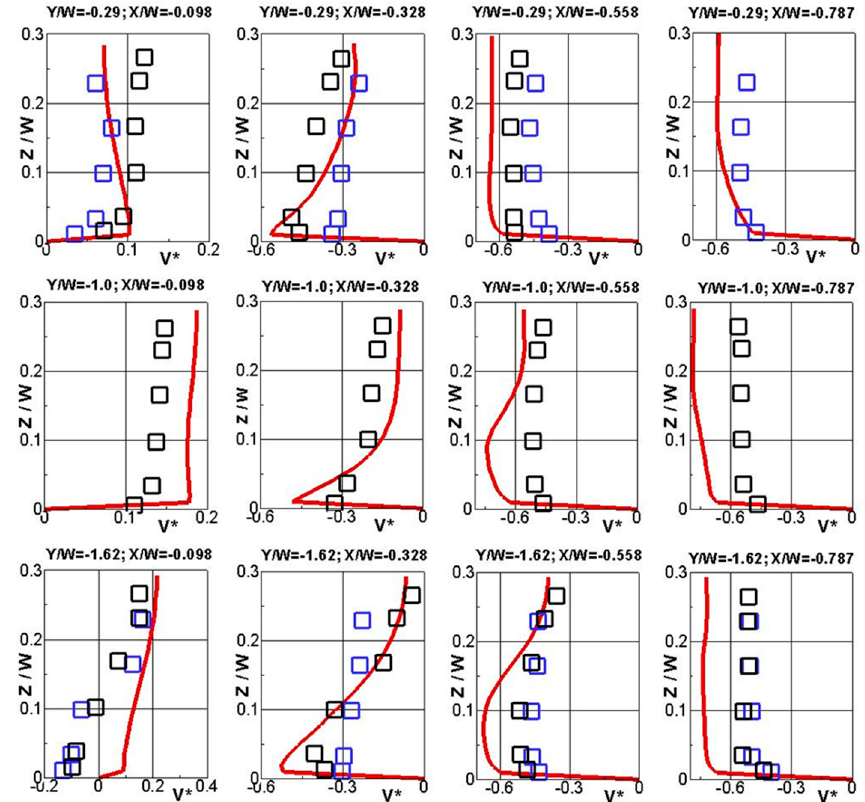
Figure 4. Comparison of v-velocity vertical profiles in the side channel at measured horizontal (xy) points; black symbols are the measured data from Ramamurthy et al. [3] while blue symbols are according to Qu [55].